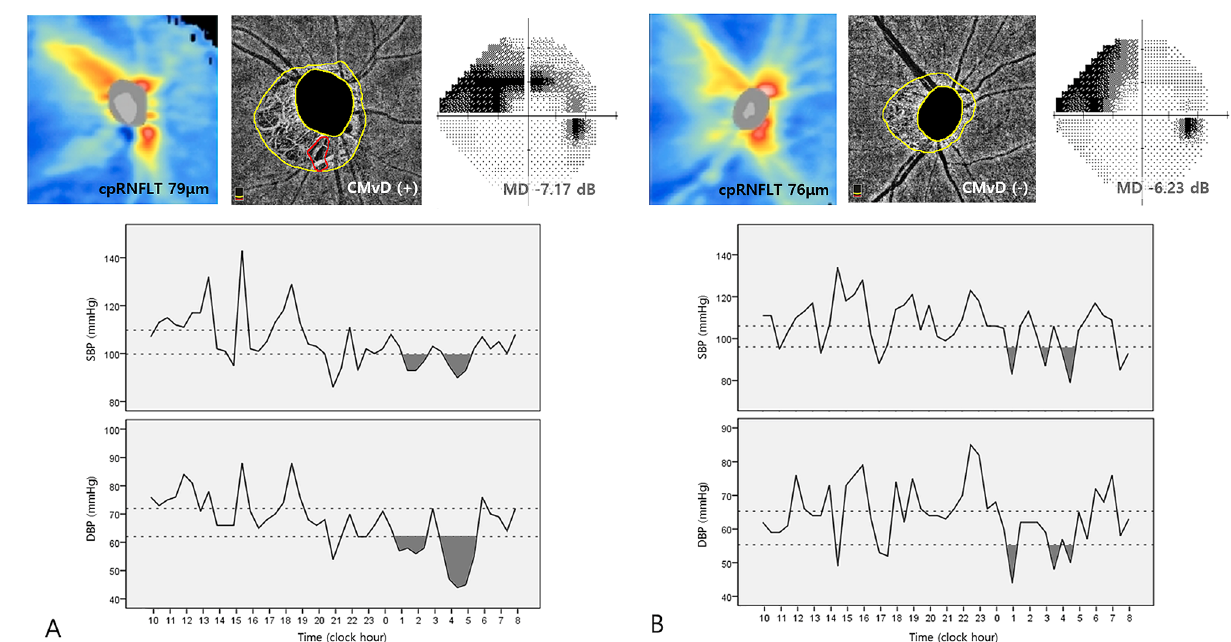
Figure 2. Representative cases of normal-tension glaucoma eyes with and without choroidal microvasculature dropout (CMvD). A 52-year-old woman with CMvD as indicated by red outline in the β-zone parapapillary atrophy shown by yellow outlines ( A ) and a 56-year-old woman without CMvD ( B ) had similar circumpapillary retinal nerve fibre layer loss (thickness, 79 μm vs. 76 μm) in the inferotemporal area and visual field defect (mean deviation, − 7.17 dB vs. − 6.23 dB, respectively) in the superior hemifield. Nevertheless, 24-h blood pressure (BP) patterns showed differences depending on the presence of CMvD. Nighttime diastolic BP (DBP) in the eye with CMvD showed a longer duration and greater magnitude of BP dip (black area; at least 10 mmHg below the mean daytime BP) than those in the eye without CMvD. However, nighttime systolic BP (SBP) showed similar patterns of BP dip in eyes with and without